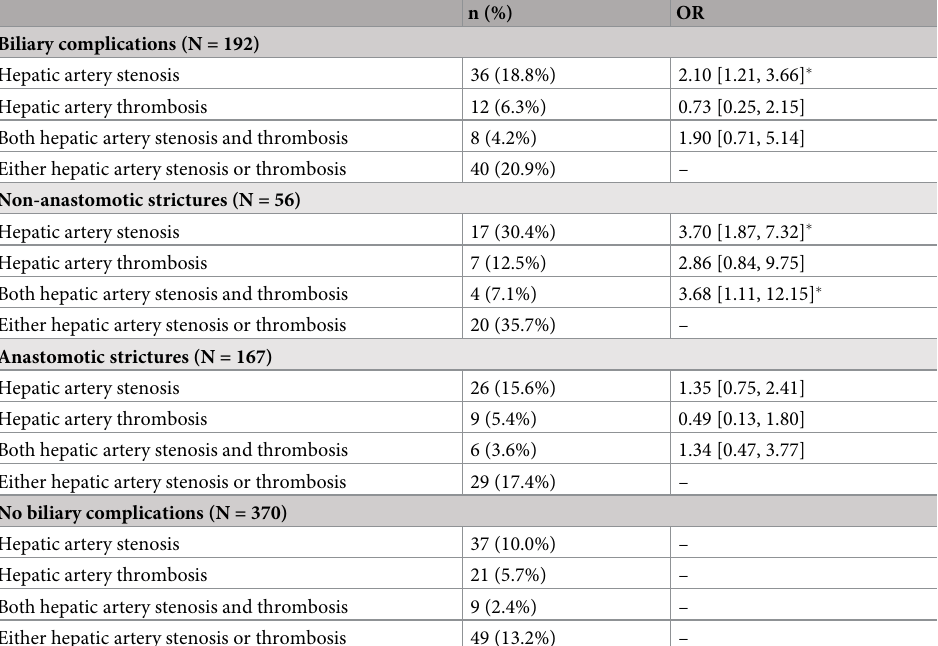
Table 6. Cross–sectional association between hepatic artery complications and biliary